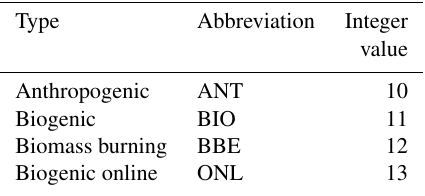
Table 2. Notation of the abbreviations used for different types of emissions denoted as X in the name structure of the files together with the corresponding integer value used in